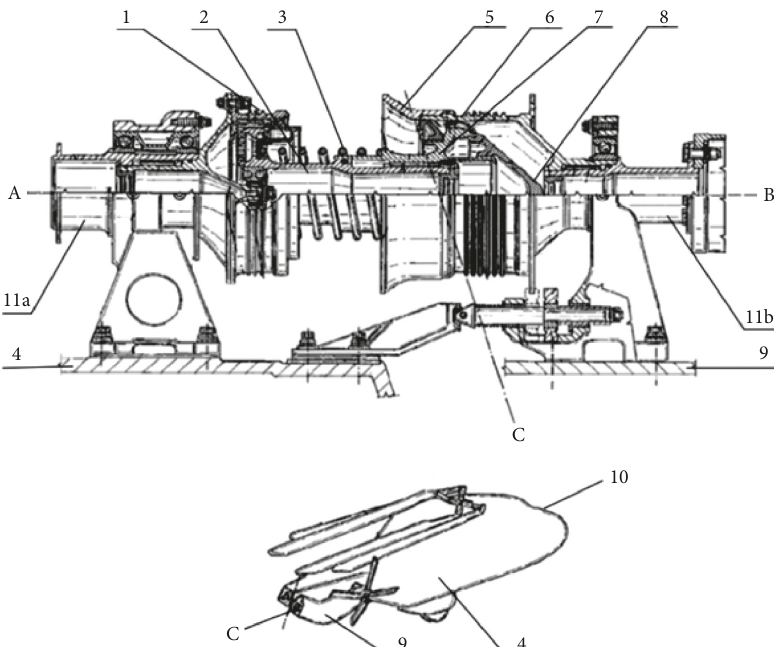
Figure 1: Two-dimensional structural diagram of folding device of the helicopter tail paddle drive system [5]. (1) Input flange. (2) Spline shaft. (3) Spring. (4) Fuselage. (5) Lead-in element disk. (6) Output flange. (7) Drum tooth. (8) Centering warhead. (9) Tail rotor. (10) Helicopter. (11(a)) Input shaft. (11(b)) Output shaft.